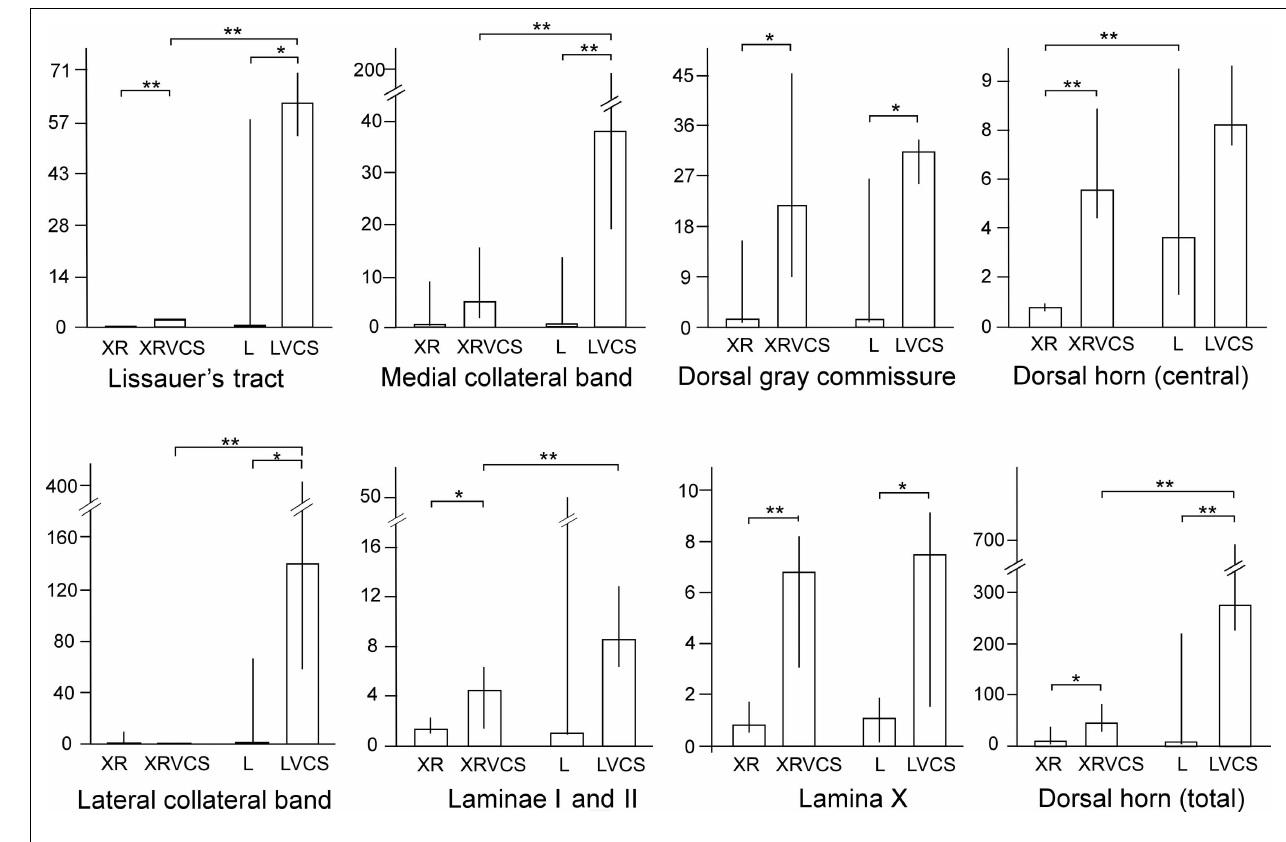
FIGURE 2 | In rats that received daily repeatedVCS, there was increased HRP labeling in the terminal fields of the pelvic nerve at L6–S1 compared to rats that did not receive suchVCS, suggesting that the daily repeatedVCS induced sprouting (details in the text). The y -axes depict the number of HRP particles/1 × 10 4 μ m 2 . XR, HRP counts on the right side of the spinal cord; XRVCS, HRP counts on the right side of the spinal cord after 1 week of daily repeatedVCS; L, HRP counts on the left side of